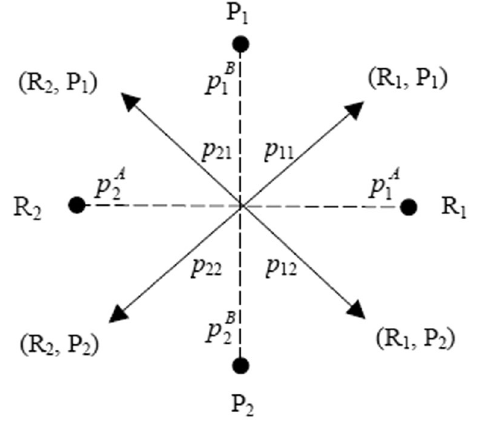
Fig. 11 Nodes and probabilities of the